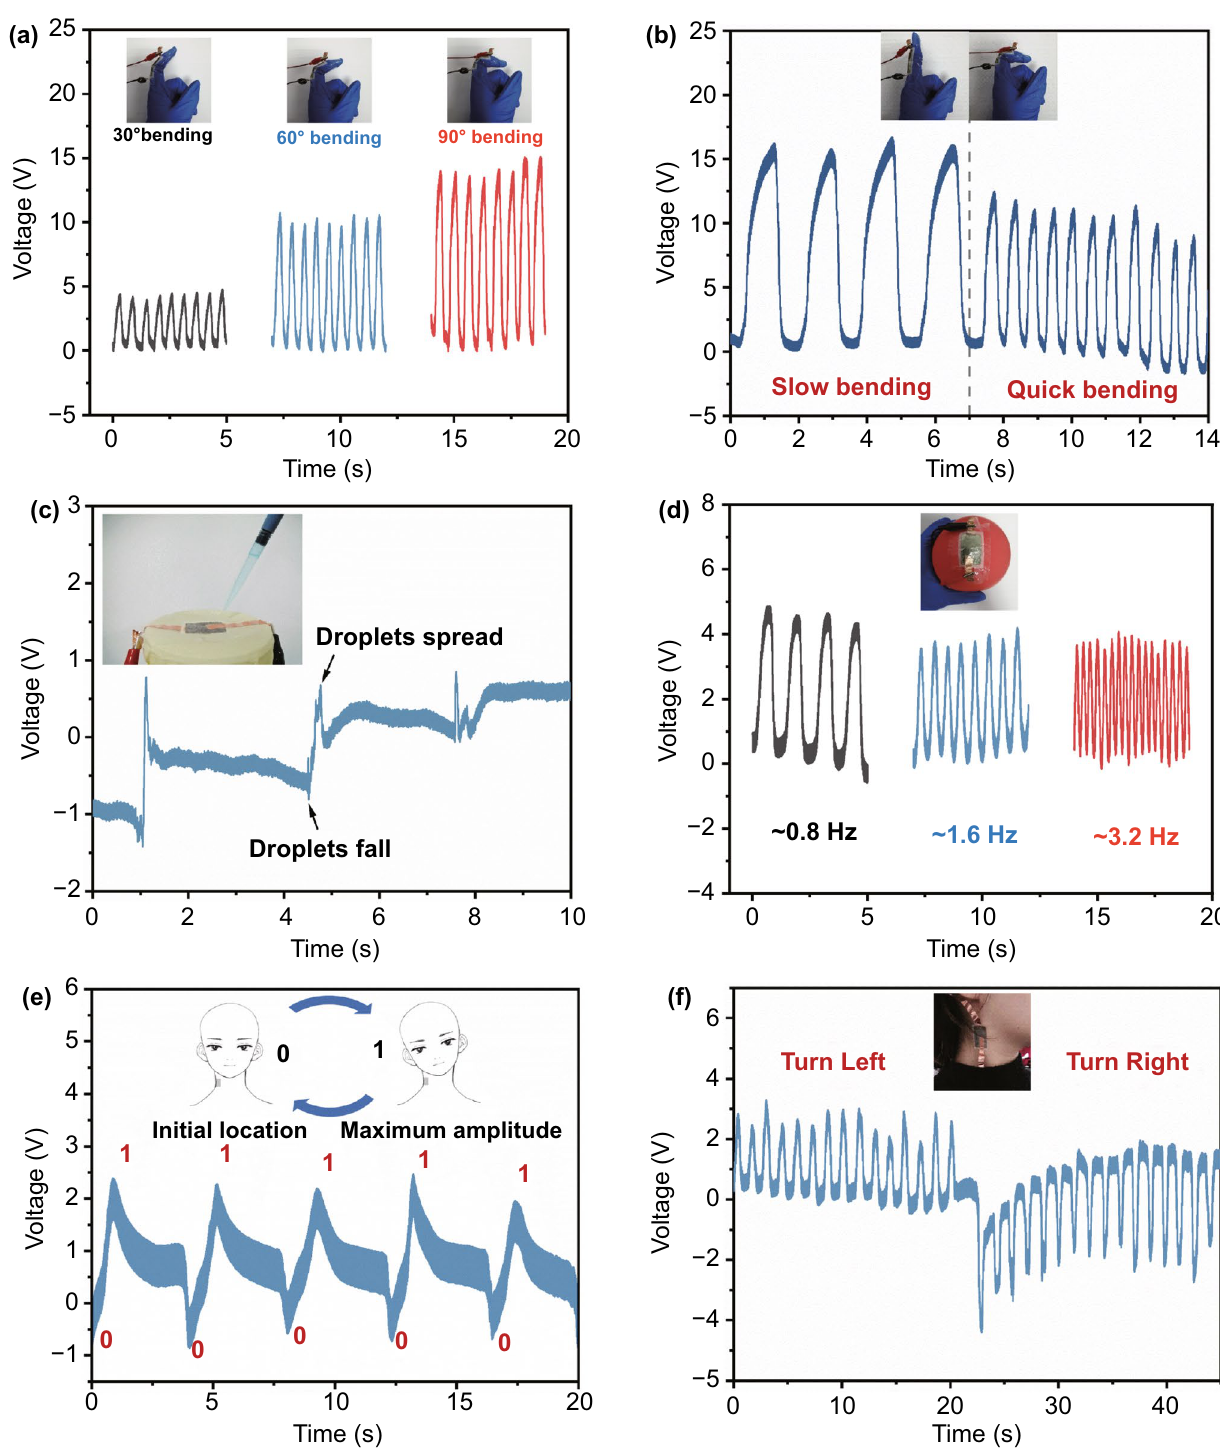
Fig. 4 Output voltage of BTS-GFF/PVDF sensors when the finger is bent at a different angle (30°, 60°, 90°) and b different speeds. c Voltage signal generated by BST-GFF/PVDF sensor under falling water droplets. The output voltage of BTS-GFF/PVDF sensors when d pressing the balloon at different frequencies (~ 0.8 Hz, ~ 1.6 Hz, ~ 3.2 Hz), e the tester deflects her head to the left at a continuous frequency of 0.25 Hz and f the tester turns her head left and right at the frequency of 0.75